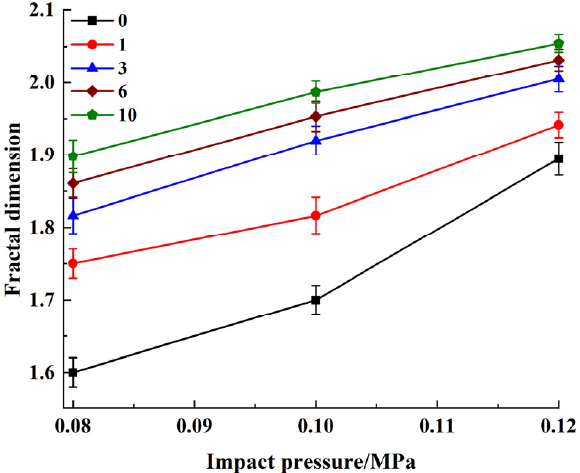
Figure 12. Impact pressure effect on fractal dimension.